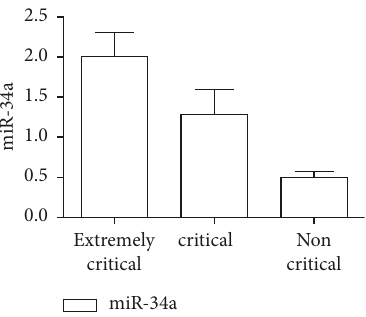
Figure 1: Comparison of serum miR-34a in children with different severity of RDS.